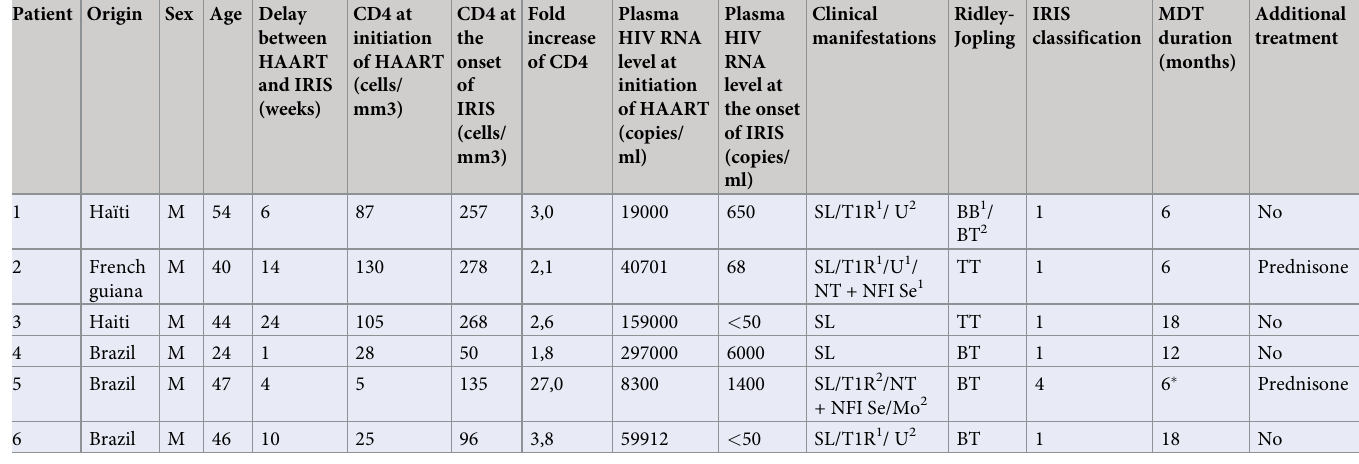
Table 1. Epidemiological, clinical and biological characteristics of the 6 patients included in the retrospective study diagnosed with leprosy as IRIS in French Gui- ana between 2000 and 2020. M: male; RNA: ribonucleic acid; SL: skin lesion(s); T1R: type 1 reaction; U: ulceration; NT: neuritis; NFI: nerve fonction impairment; Se: sen- sitive; Mo: motor; 1 : before MDT introduction; 2 : after MDT introduction; TT: polar tuberculoid; BT: borderline tuberculoid; BB: borderline borderline; PB: paucibacillary; MB: